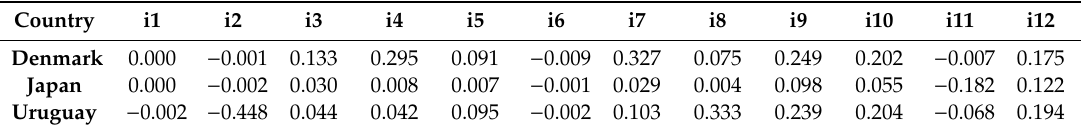
Table 6. Necessary improvements to make a country e ffi cient. These improvements need to be achieved on all inputs cumulatively or all outputs cumulatively. The full table for all countries is available in the ESI, Table